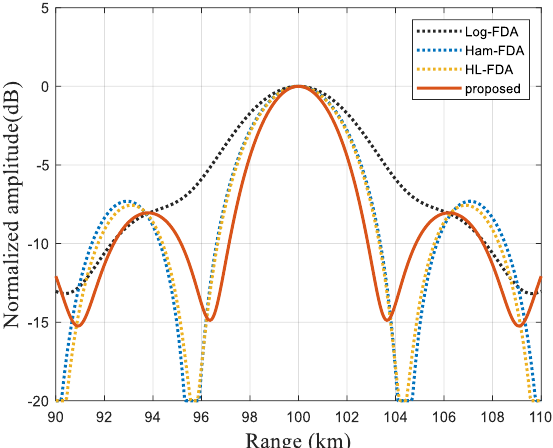
Figure 6. Range-Dimensional Slicing Performance Comparison.